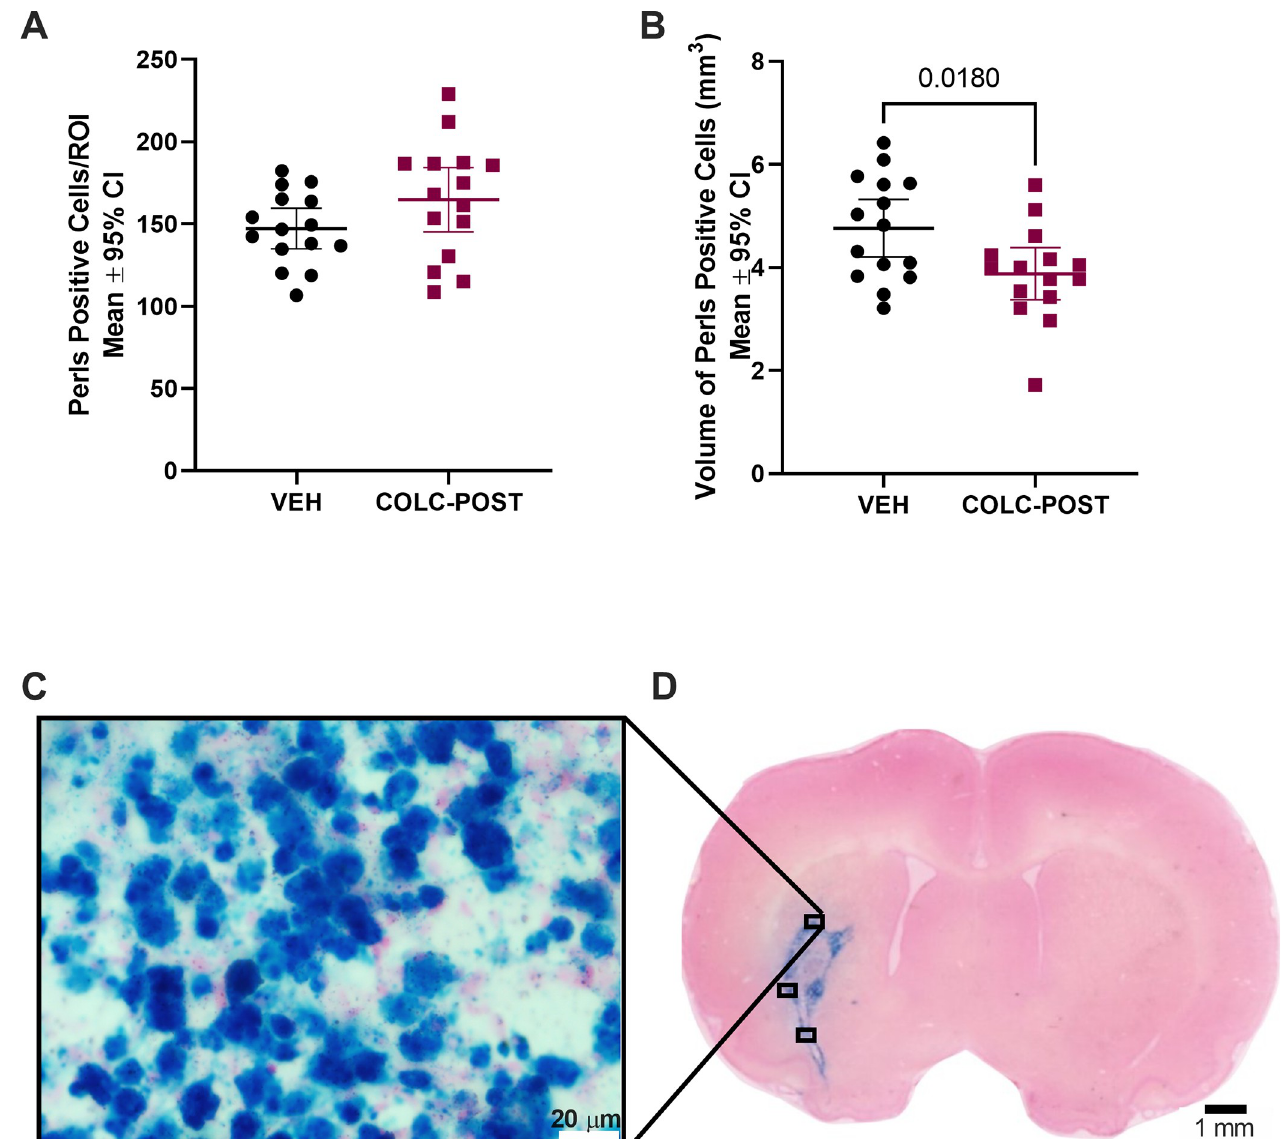
Fig 6. Experiment 4 Perls staining. Post-ICH colchicine administration did not affect the number of Perls positive cells per region of interest (A, p = 0.115), but did reduce the average volume of brain containing Perls positive cells (B, p = 0.018, average area of blue tissue multiplied by section interval and number of sections) at 14 days post-ICH. C. Perls positive cells under 40 × magnification. D. Representative image of Perls staining. White scale bar represents 20 μ m, black scale bar represents 1